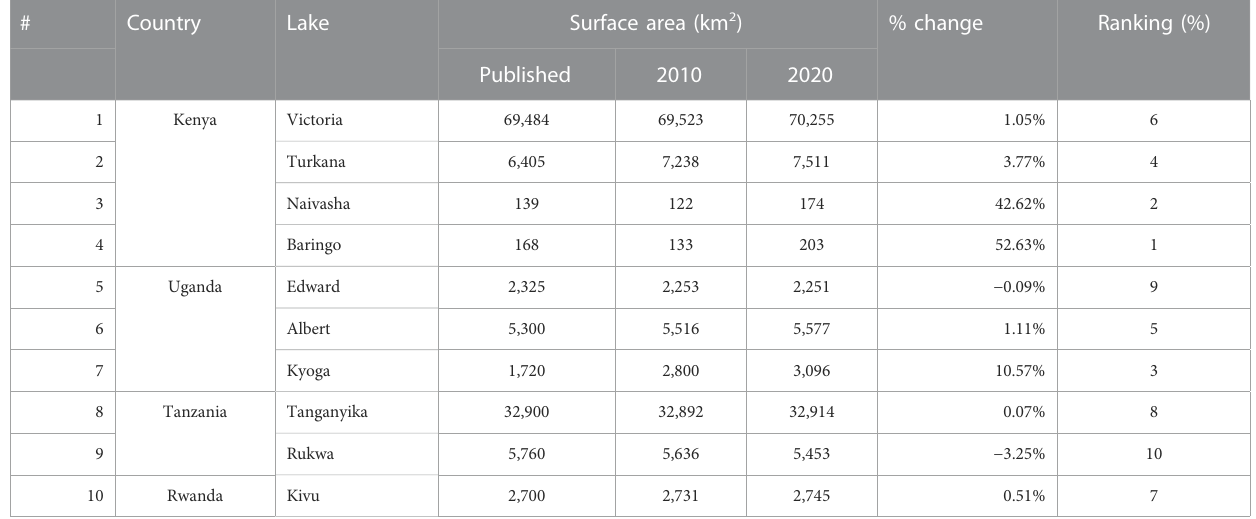
TABLE 1 Calculated areal extent (km 2 ) and percentage change in surface area of the selected major African lakes due to fl ooding in the years 2010 and